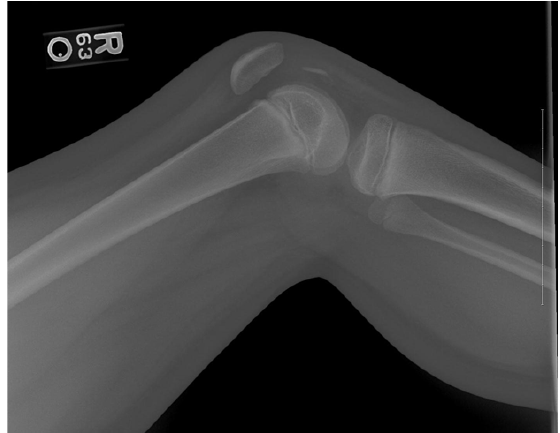
Figure 1. This is the initial lateral view of the patient’s knee demonstrating patella alta and a 1.3cm ossific fragment representing an avulsion with partial rupture of the patellar